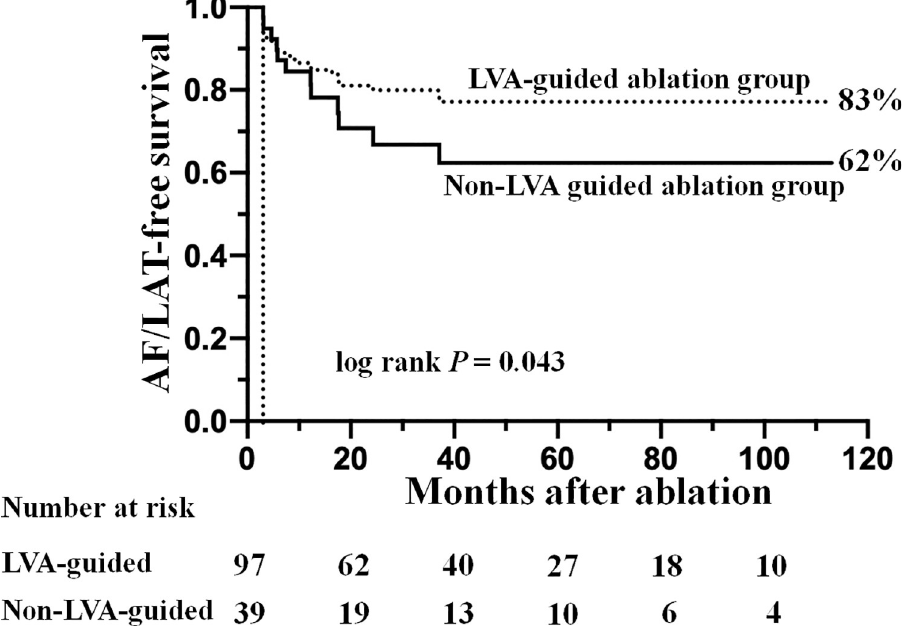
Fig 2. The Kaplan-Meier estimates of freedom from atrial fibrillation (AF)/left atrial tachycardia (LAT) in the low-voltage area (LVA)-guided (dashed line) and non-LVA-guided (solid-line) linear ablation groups.